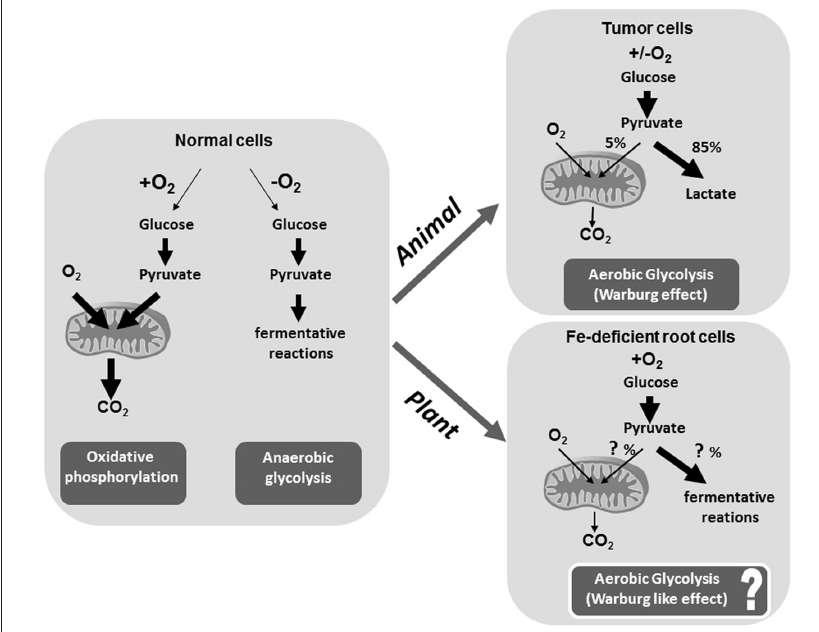
Figure 1 | Schematic representation of the differences between oxidative phosphorylation, anaerobic glycolysis, and aerobic glycolysis (Warburg effect) in animals and iron deficiency-induced metabolic responses in plant cells. In the presence of oxygen, normal cells (both animal and plant) first metabolize glucose to pyruvate via glycolysis and then completely oxidize most of that pyruvate in the mitochondria during oxidative phosphorylation (OXOPHOS). When oxygen is limiting, cells can redirect the pyruvate generated by glycolysis away from mitochondrial OXOPHOS by inducing a fermentative pathway (anaerobic glycolysis). The Warburg effect observed in cancer cells tend to convert most glucose to lactate regardless of whether oxygen is present or not (aerobic glycolysis). A similar Warburg effect could be observed also in Fe-deficient plant cell, in which the slowed OXOPHOS, because of the lack of Fe, determine the up-regulation of glycolysis–fermentative reactions. Since this metabolic switch occurred in the presence of oxygen, we can consider it as the induction of aerobic glycolysis. (The Figure is a adaptation/reinterpretation of Figure 2 reported in Vander Heiden et